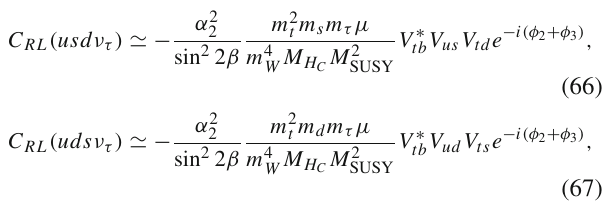
smaller than that corresponding to the combined uncertainty from the hadronic matrix elements and α s (lower dotted